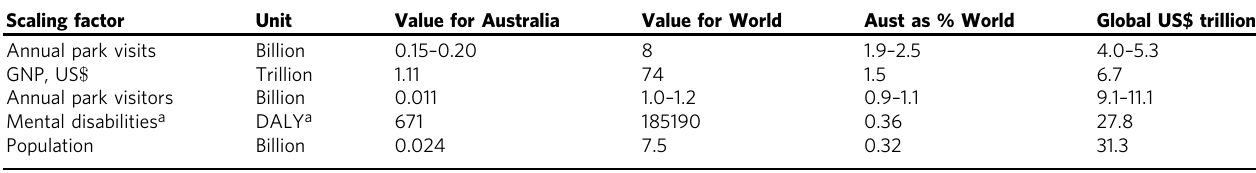
Data from Australian state and national agencies; global agencies; and research articles 18,23,112 – 119 a Burden of mental and behavioural disorders, excluding neurological, measured in disability-adjusted life